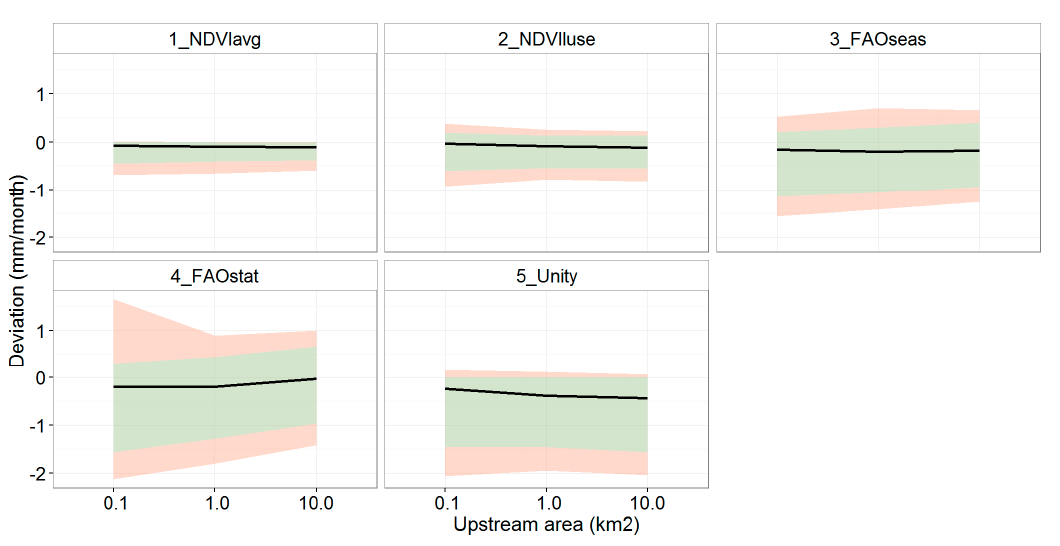
Figure 8 . Streamflow deviations for all methods, with 50th percentile (black line), the interval between the 10th and 90th percentiles (green), and the 5th and 95th percentiles (red).